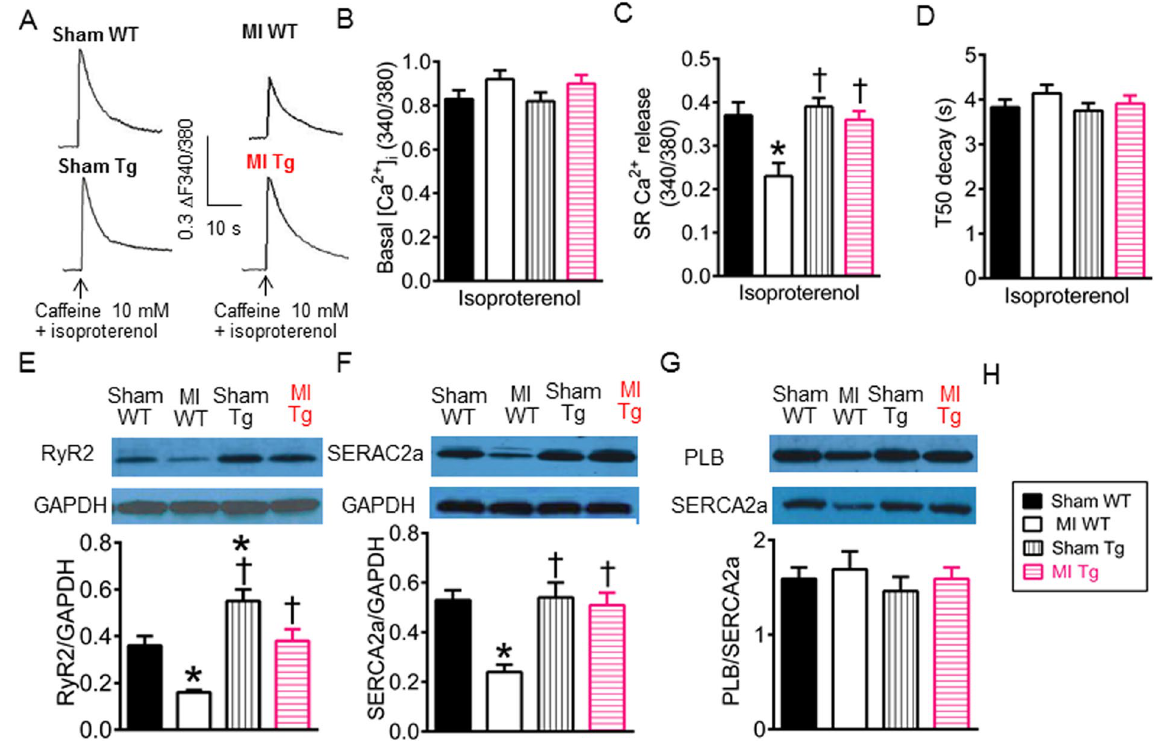
Figure 7. Effects of GTP cyclohydrolase 1 (GCH1) overexpression on sarcoplasmic reticulum (SR) Ca 2 + release and Ca 2 + handling proteins after myocardial infarction (MI). ( A ) Original recordings of caffeine-induced Ca 2 + release in cardiomyocytes isolated from wild-type (WT) and transgenic (Tg) mice 4 weeks after MI or sham surgery in 0 Na + and 0 Ca 2 + Tyrode buffer under isoproterenol stimulation. The vertical scale bar indicates 0.3 Fura-2 ratio unit, and the horizontal bar indicates 10 s; ( B ) Basal [Ca 2 + ] I in the presence of isoproterenol; ( C ) SR Ca 2 + release in the presence of isoproterenol (n = 63–66 cells/group); ( D ) Time to 50% decay (T50 decay) of caffeine-induced Ca 2 + transients in the presence of isoproterenol; ( E ) The expression of ryanodine receptors (RyR2) normalized to glyceraldehyde 3-phosphate dehydrogenase (GAPDH) in Tg and WT mice 4 weeks after MI or sham surgery (n = 5 mice/group). Top: Wesern blot bands showing the expression of RyRs and GAPDH. Bottom: the ratio of RyRs/GAPDH; ( F ) The expression of SR Ca 2 + -ATPase (SERCA2a) proteins normalized to GAPDH. Top: Western blot bands showing the expression of SERCA2a and GAPDH. Bottom: the ratio of SERCA2a/GAPDH; ( G ) The expression of phospholamban (PLB) and SERCA2a in Tg and WT mice 4 weeks after MI or sham surgery. Top: Western blot bands showing the expression of PLB and SERCA2a. Bottom: the ratio of PLB/SERCA2a. * P < 0.05 versus sham WT groups; † P < 0.05 versus MI WT